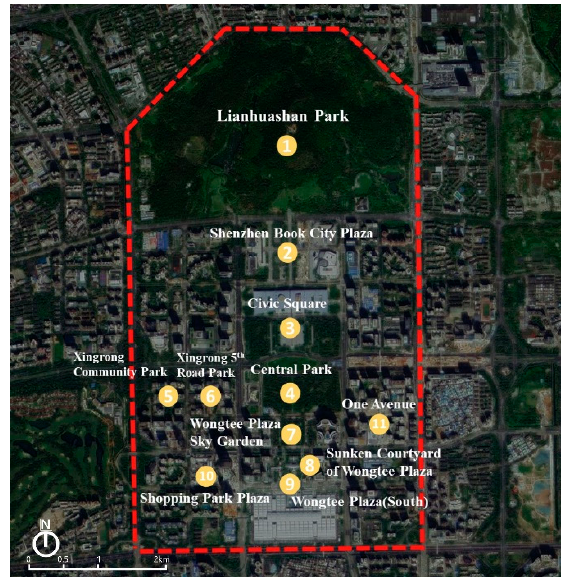
Figure 2. Green space distribution in study area. Table 1. Status of green space in Futian CBD.